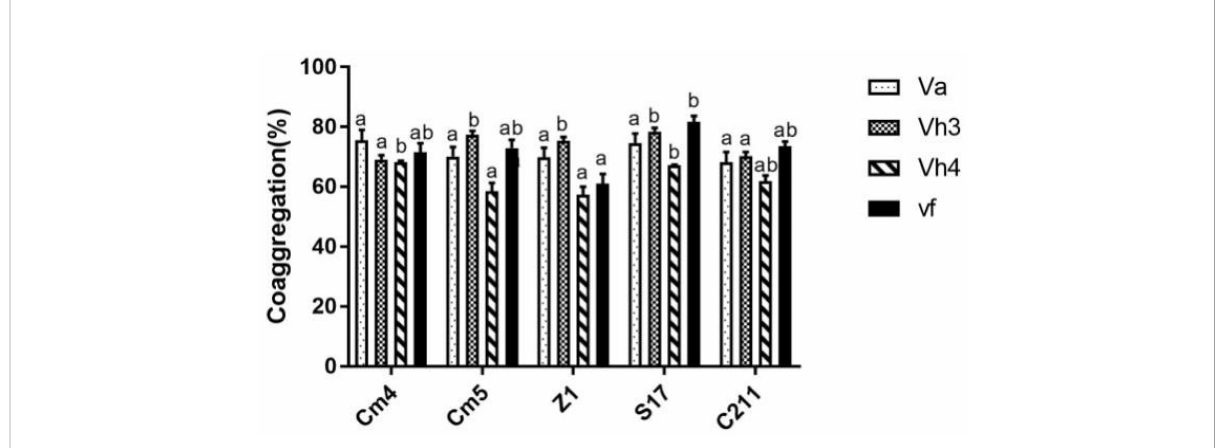
FIGURE 7 Co-aggregation percentages of selectedstrains with pathogens after 6h.Va, Vibrio anguillarum CECT4344; Vh3, V.harveyi Lg 26/01; Vh4, V. harveyi Lg 48/01; Vf, V. fi scherie . Data arepresented as mean ± SD (n=3) withdifferent superscript letters denoting a signi fi cant differences (p<0.05).